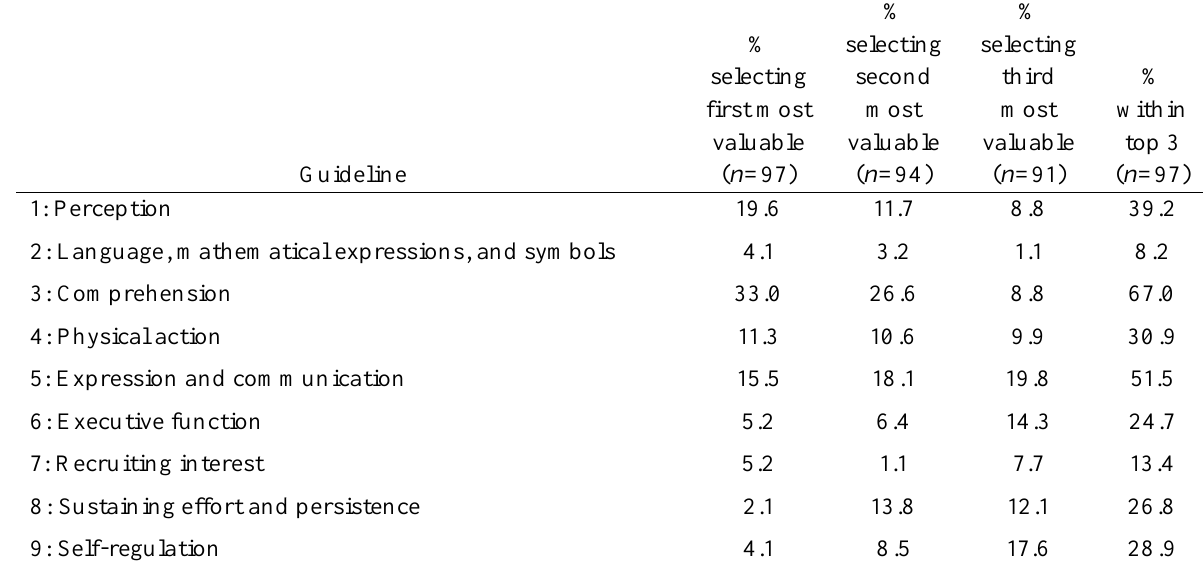
Table 10 Faculty Ranking of the Top Three Most Valuable UDL